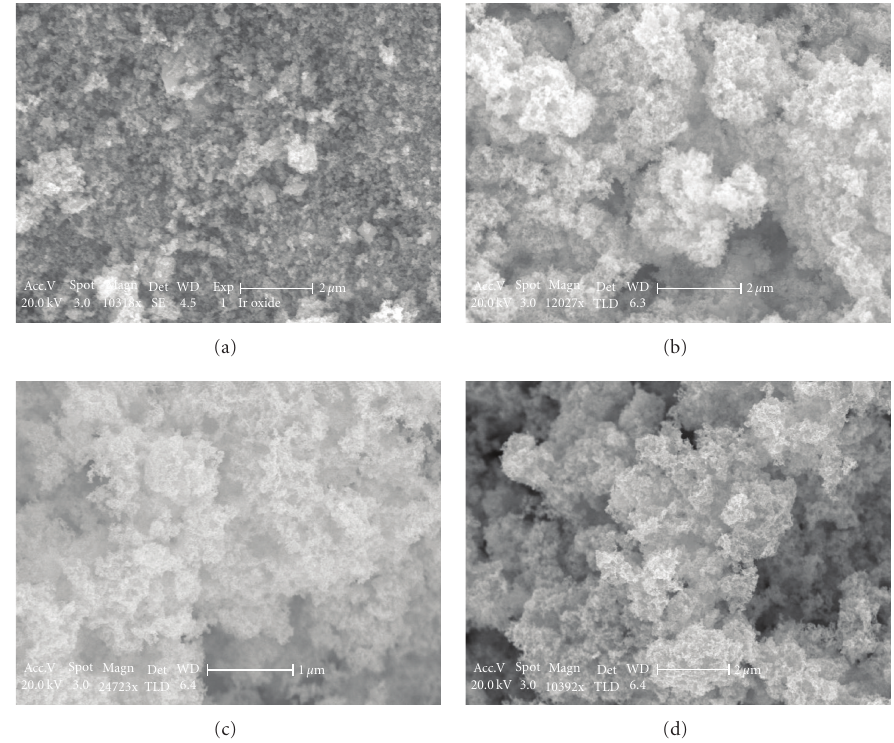
Figure 2: Scanning electronic micrographs of (a) amorphous IrO 2 , (b) 7/93, (c) 11/89, and (d) 14/86 IrO 2 /Pt catalysts.